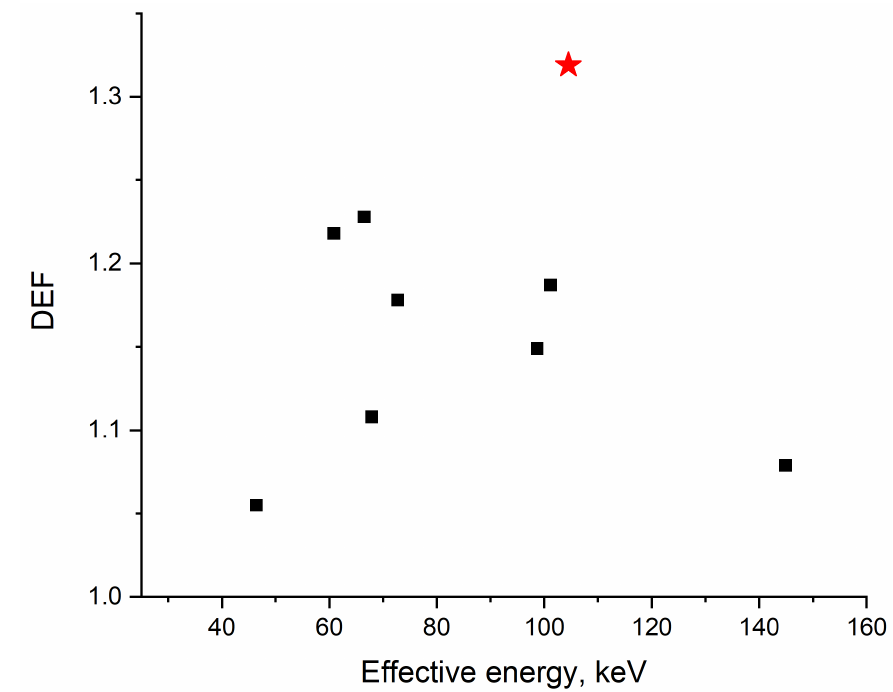
Figure 10. Comparison of calculated physical dose enhancement factor (DEF) for X-ray spectra with various e ff ective energies at a voltage of 200 kVp (black dots, see supplementary files) with DEF for the spectrum of RUST-M1, used in our study (red